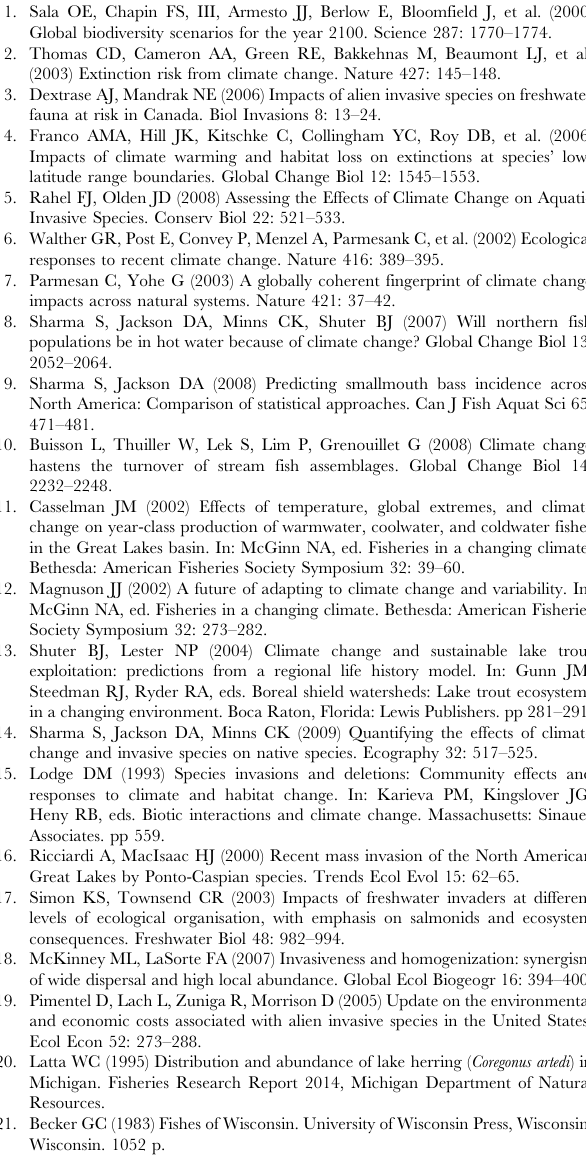
Table S1 Summary of climate change models